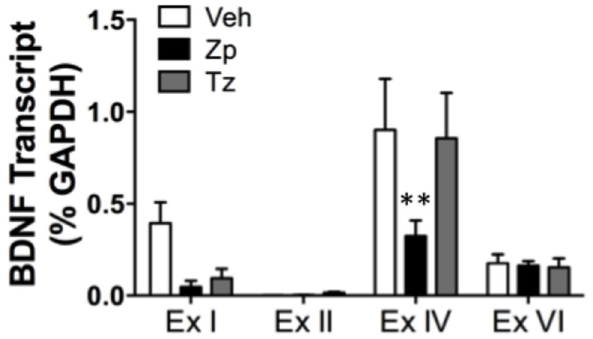
Figure 2. BDNF exon IV-containing transcript is decreased following acute ZP treatment. There is a selective and